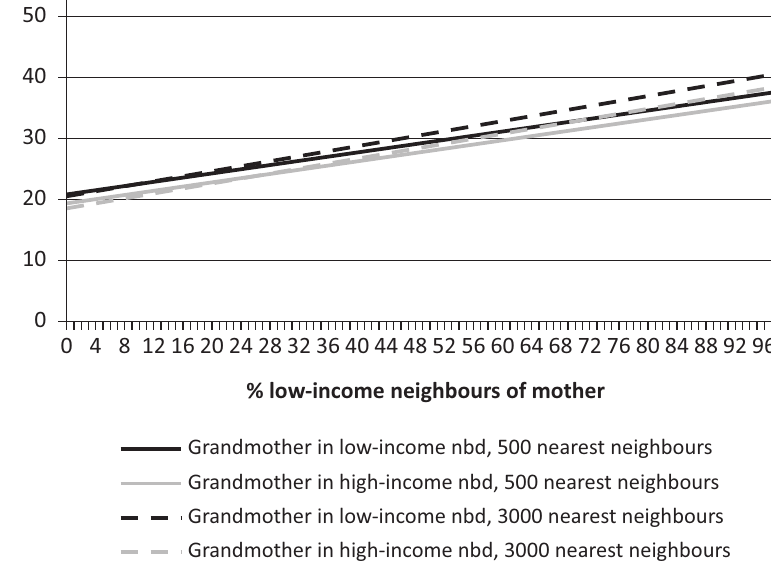
Figure 2. Predicted share low-income neighbours of the daughter by share low-income neighbours of the mother, for an individual of mean age, income and distance to mother/grandmother, mode education level and family status. Notes: Grandmother in high- or low-income neighbourhood, varying scale; strategy 1.